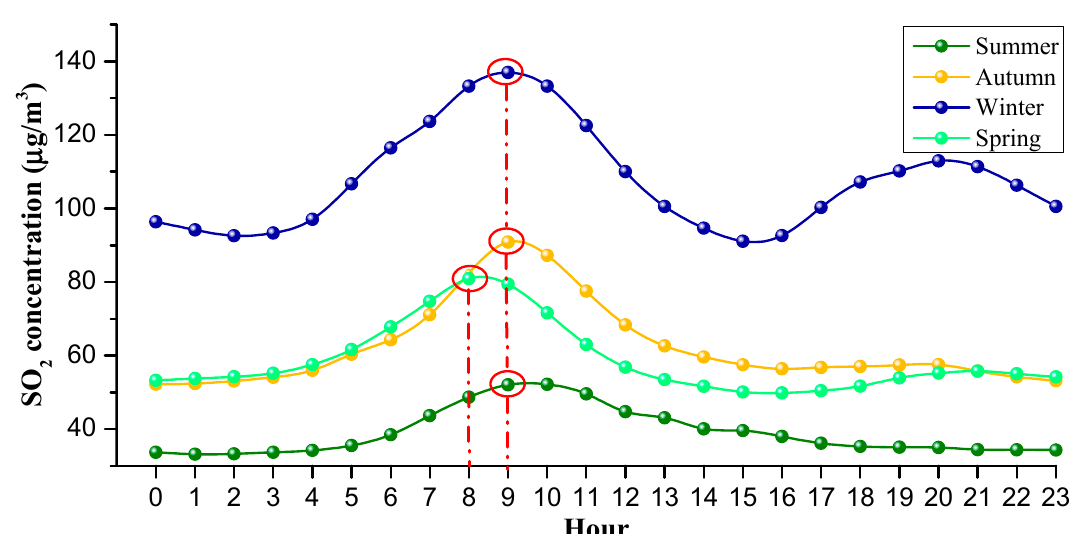
Figure 9. Hourly average concentration of SO 2 in different seasons from 2008 to 2020. The circles mean the local maximum points in different seasons and the dotted lines describe the vertical lines corresponding to the circles.